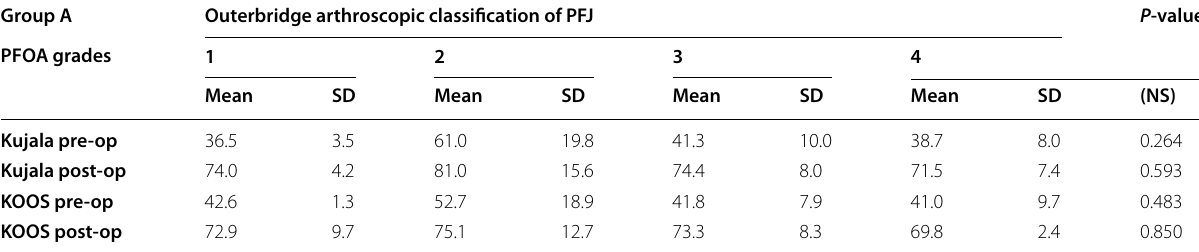
Table 11 Correlation between Outerbridge arthroscopic classification of PFJ O.A and outcome in group A Group A Outerbridge arthroscopic classification of